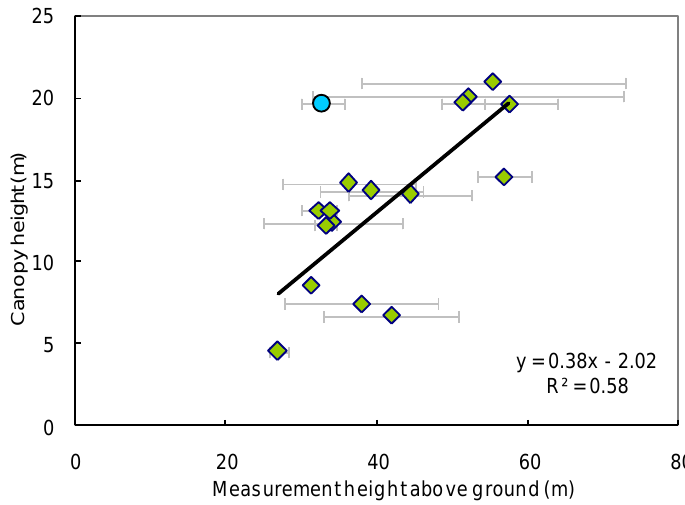
Figure 7. The relationship of the canopy height and the average altitude of the two GPS systems corresponding to the images to be used for LAI retrieval comparison with ground measurements. The missing GPS height values of the camera system were interpolated before taking the average of the two GPS systems. The terrain height was subtracted from the GPS height values. The GPS heights of the two systems are shown as error bars of the average value. The outlier (blue marker) not included in the regression corresponds to a plot, which was so close to the road, that the LAI values derived from the higher altitudes were deteriorated by